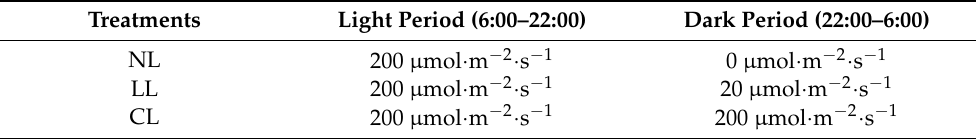
Table 1. Light intensities of light period and dark period for each treatment.